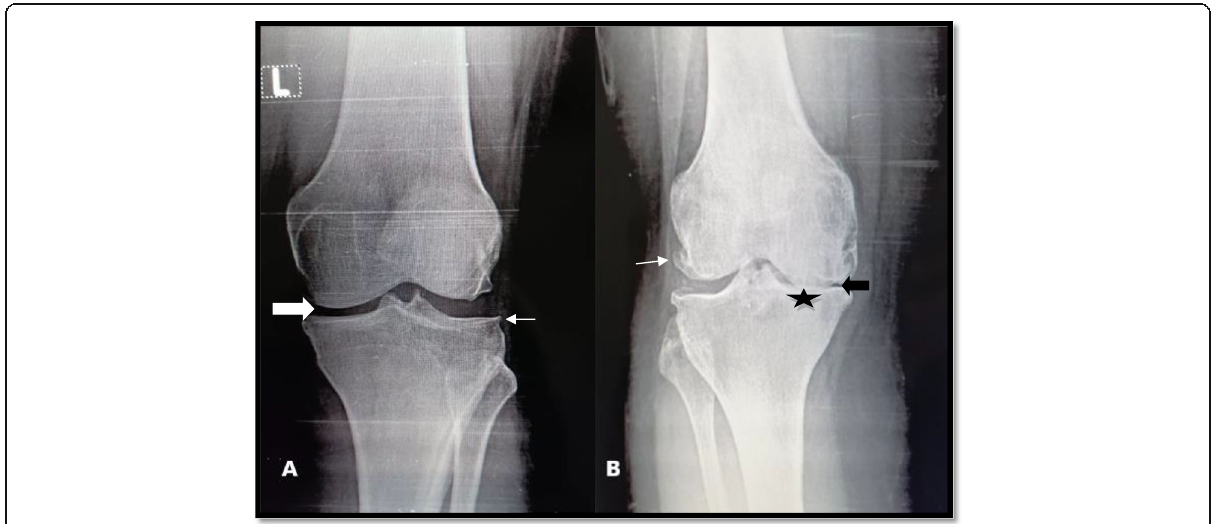
Fig. 1 The Kellgren- Lawrence radiographic osteoarthritis grading scale. a Mild osteoarthritis with small osteophites (arrows) and possible medial joint space narrowing (bold arrow). b Severe osteoarthritis with large osteophites (white arrow), marked joint space narrowing (black arrow), and subchondral sclerosis (astride)